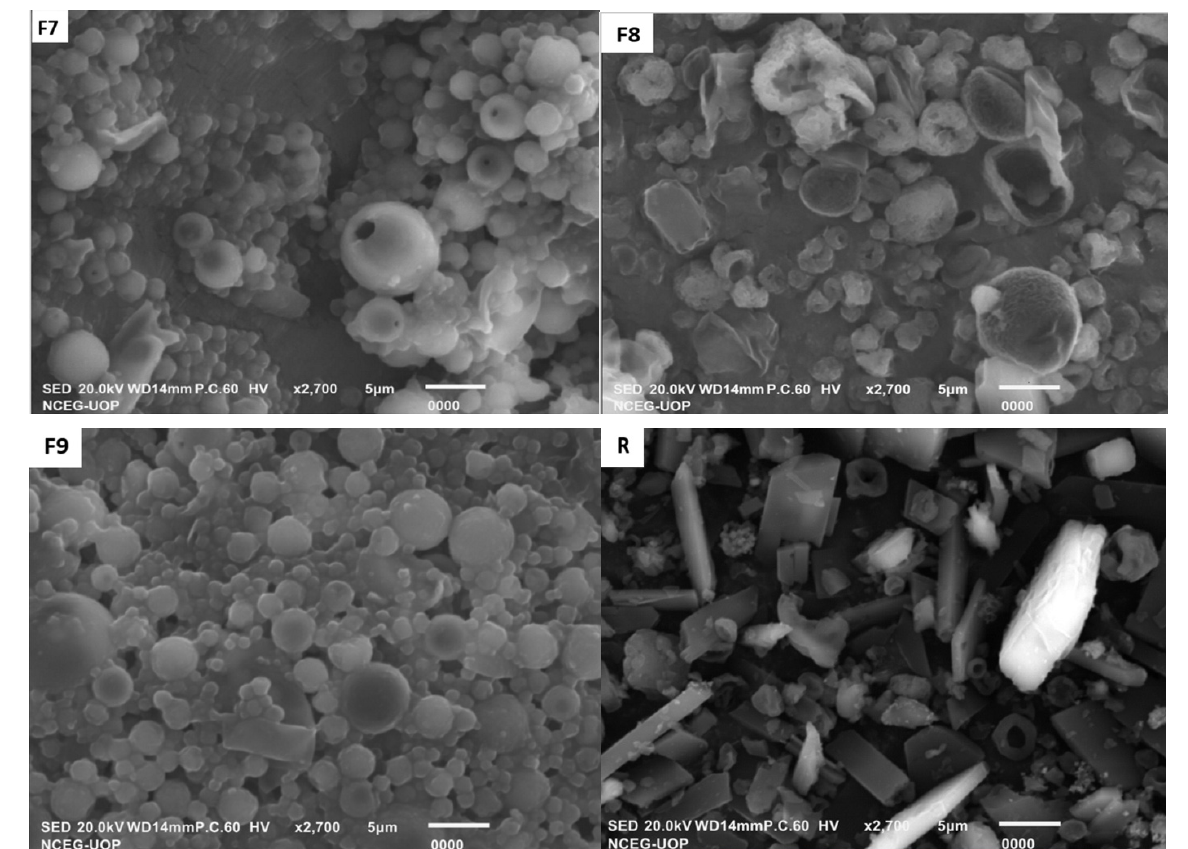
Figure 1. Morphological features of spray-dried microparticles (F1–F5) and pure rifampicin (R) and